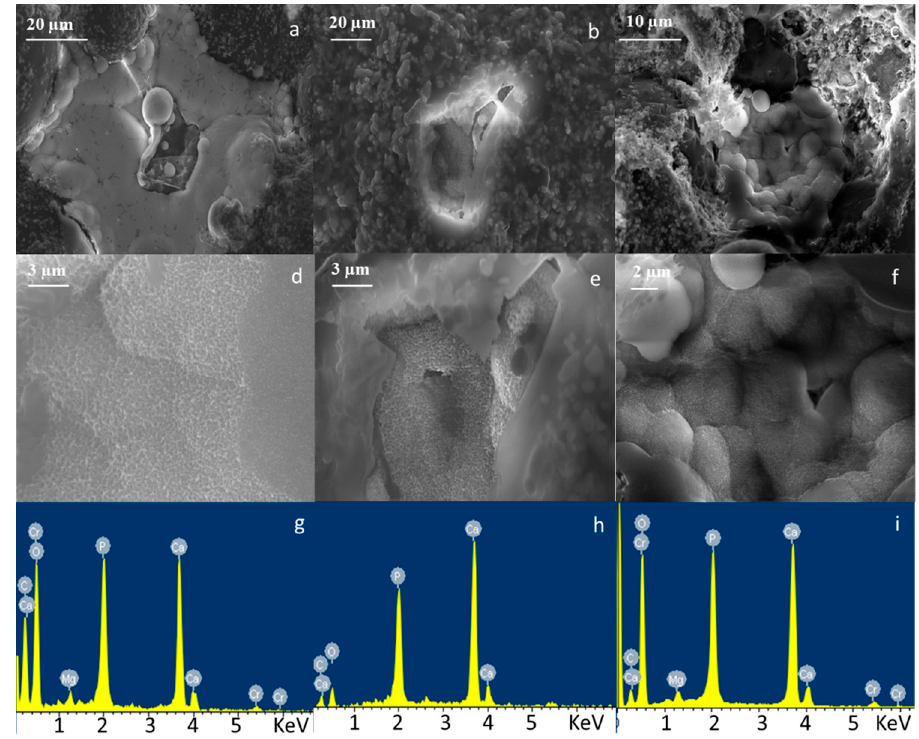
Figure 4. FESEM and EDS analysis of ( a , d , g ) CEMEX ® ISO-Cu, ( b , e , h ) CEMEX ® RX-Cu, and ( c , f , i ) CEMEX ® XL-Cu immersed in SBF solution up to 14 days.